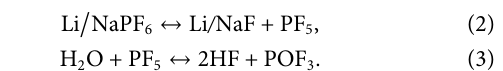
Frontiers in Energy Research |